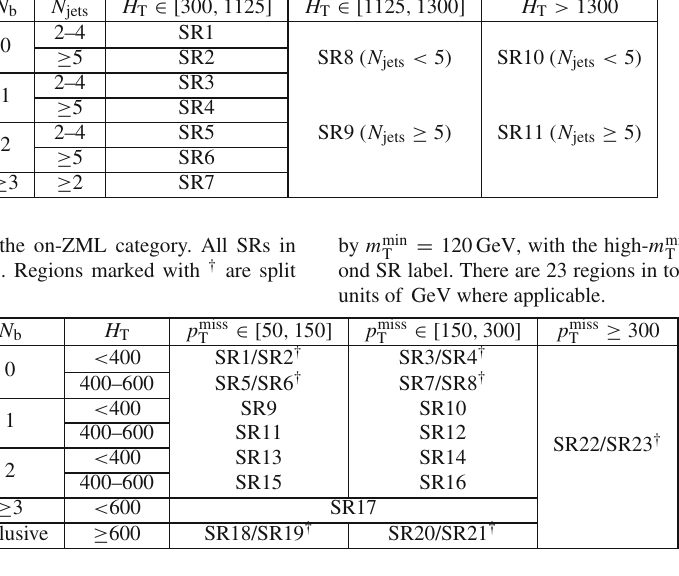
Table 7 The SR definitions for the off-Zcategory. All SRs in these categories require N jets ≥ 2. Regions marked with † are split by